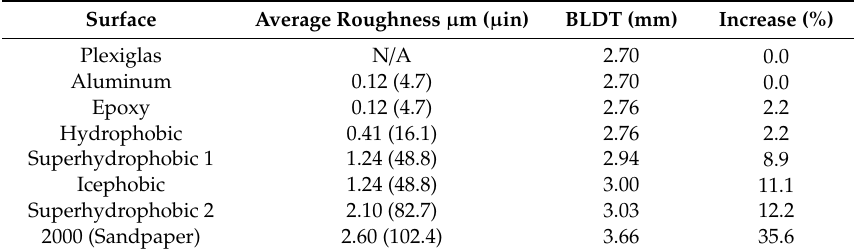
Table 4. Boundary layer displacement thickness (BLDT) results for the di ff erent surfaces.